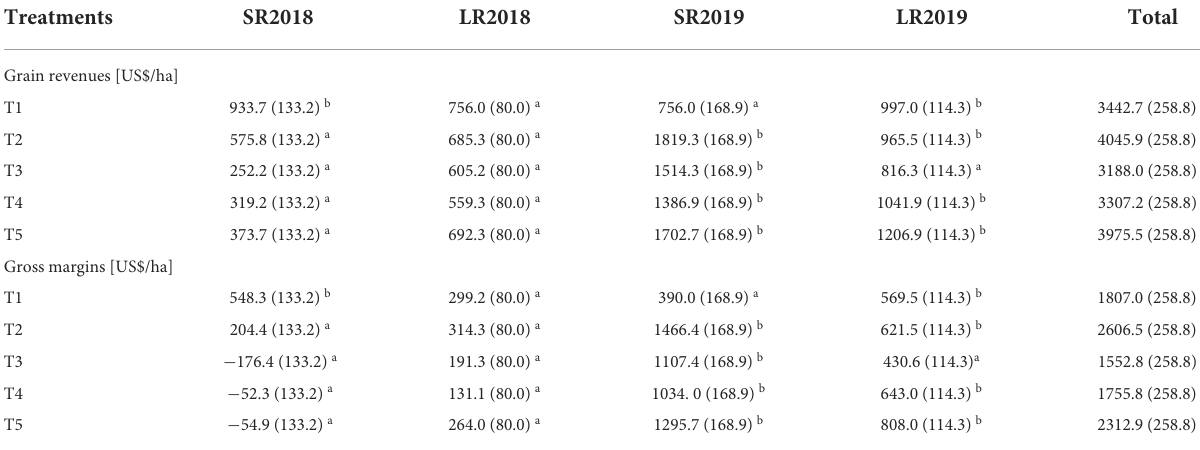
TABLE 8 Comparison of grain revenues and gross margins between treatments over 4 crop-growing seasons during 2018 and 2019.